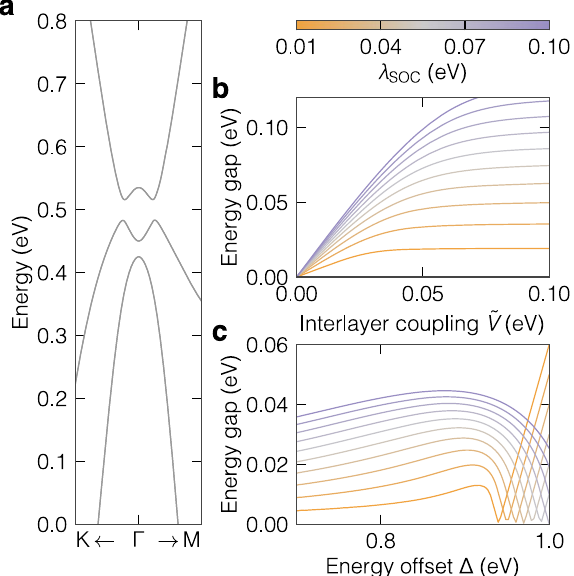
Fig. 6 Tight-binding model. a Band structure around Γ for the Slater – Koster s − p x p y tight-binding model discussed in the text, where a band inversion between the second and third band occurs at the Fermi level and is gapped by spin-orbit coupling (SOC). b Band gap as a function of the interlayer coupling ~ V for various SOC strengths ( λ SOC , color-coded lines): the gap increases linearly with ~ V until it saturates to a value of the order of λ SOC . c Band gap as a function of the energy offset Δ between orbitals on different layers for various values of λ SOC (same color coding as panel b ): in the topological phase, the gap moderately increases with the energy offset while the band inversion is reduced, until it suddenly drops to zero when the band inversion vanishes. The gap then reopens and increases linearly with Δ in the trivial insulating